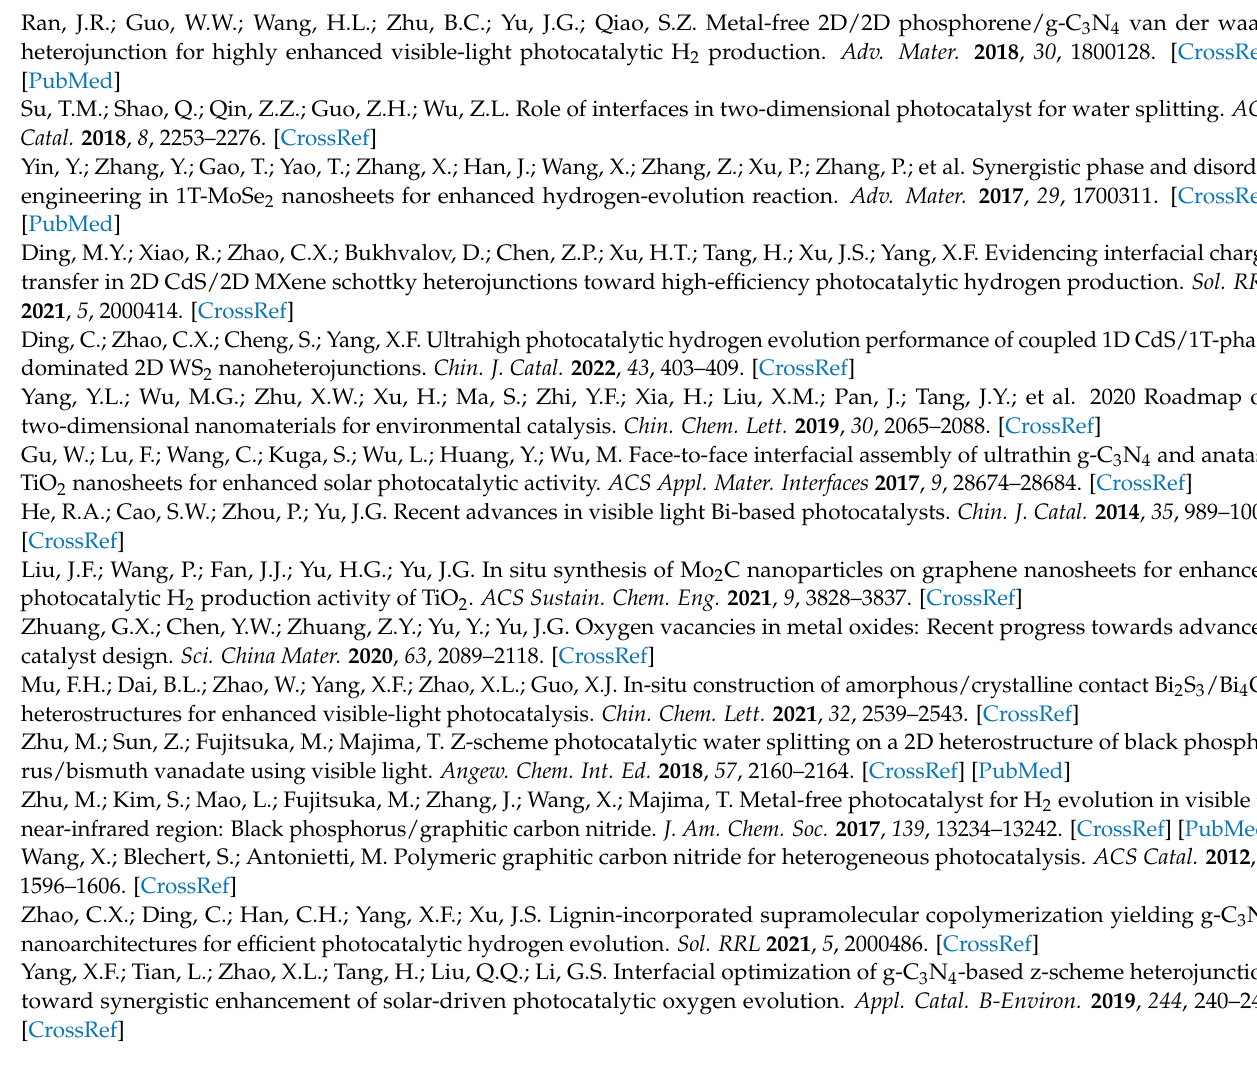
Figure S2: FTIR spectra of CNP10 and CNP10-H; Figure S3: Nyquist plots EIS spectroscopy from CNP10 and CNP10-H; Figure S4: Photocurrent response of CNP10 and